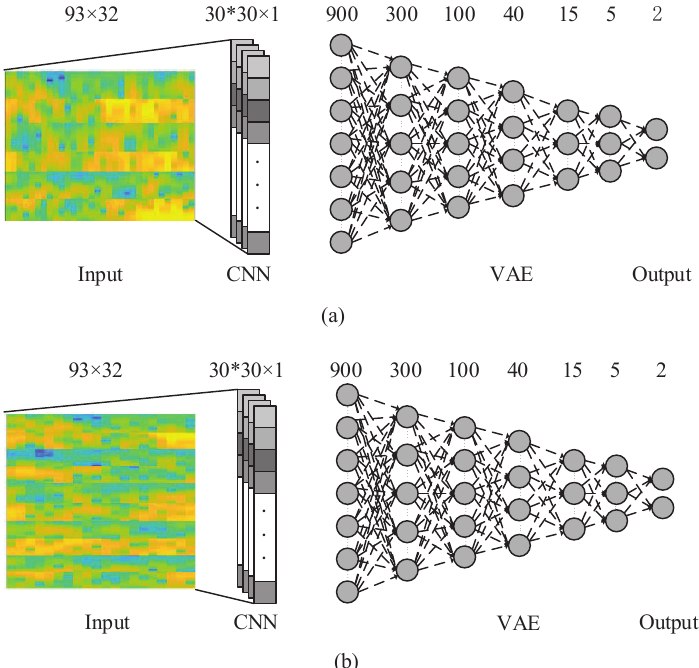
Figure 5. The proposed CNN-VAE network with 3 electrodes and 5 electrodes. ( a ) is the CNN-VAE network with 3 electrodes; ( b ) is the CNN-VAE network with 5